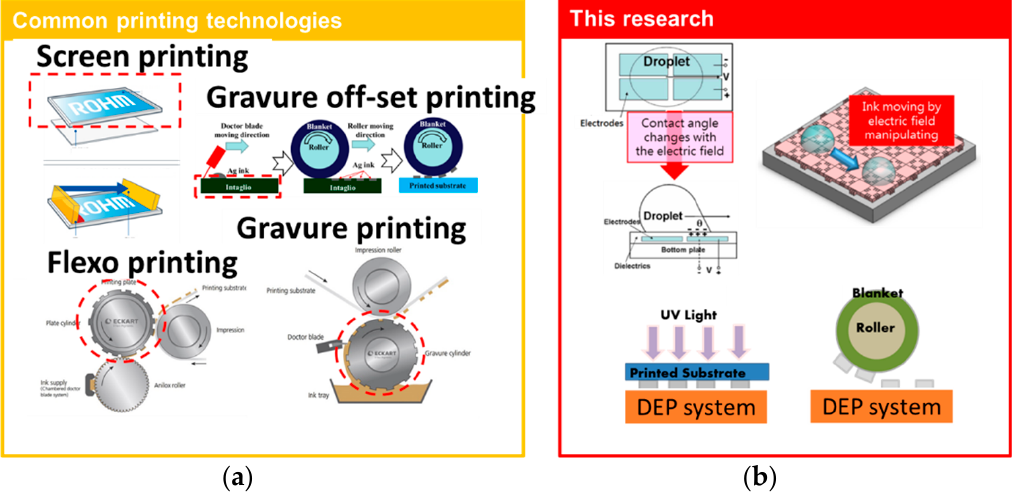
Figure 11. ( a ) All printing techniques with blading process and pattern-fixed master mold; ( b ) digital mold by DEP system without the blading process.